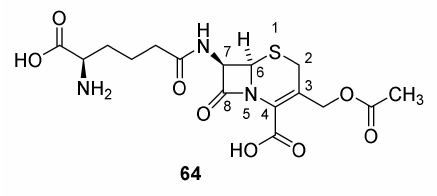
Figure 15. Cephalosporin C ( 64